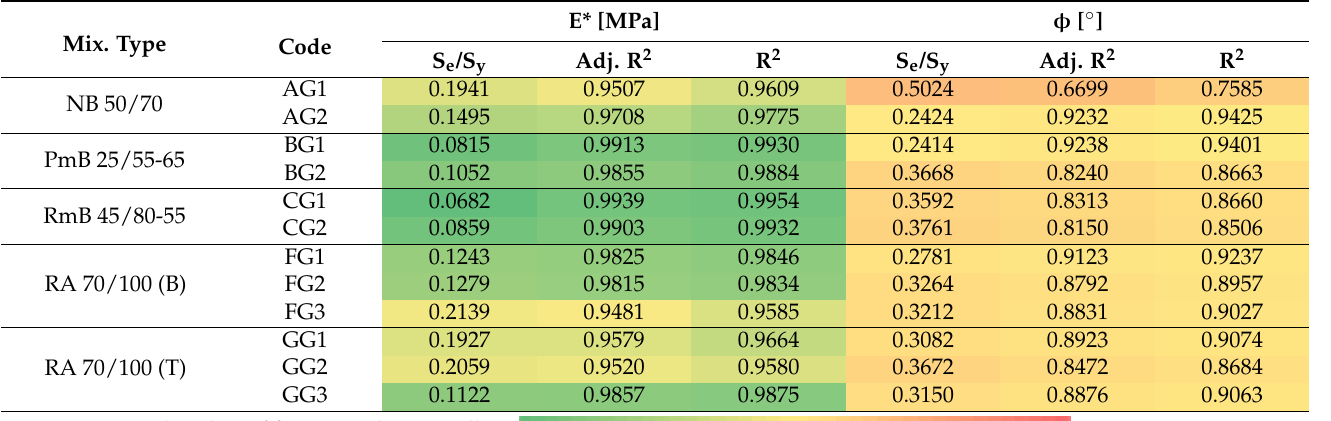
Table 5. Comparison of fits of master curve models.